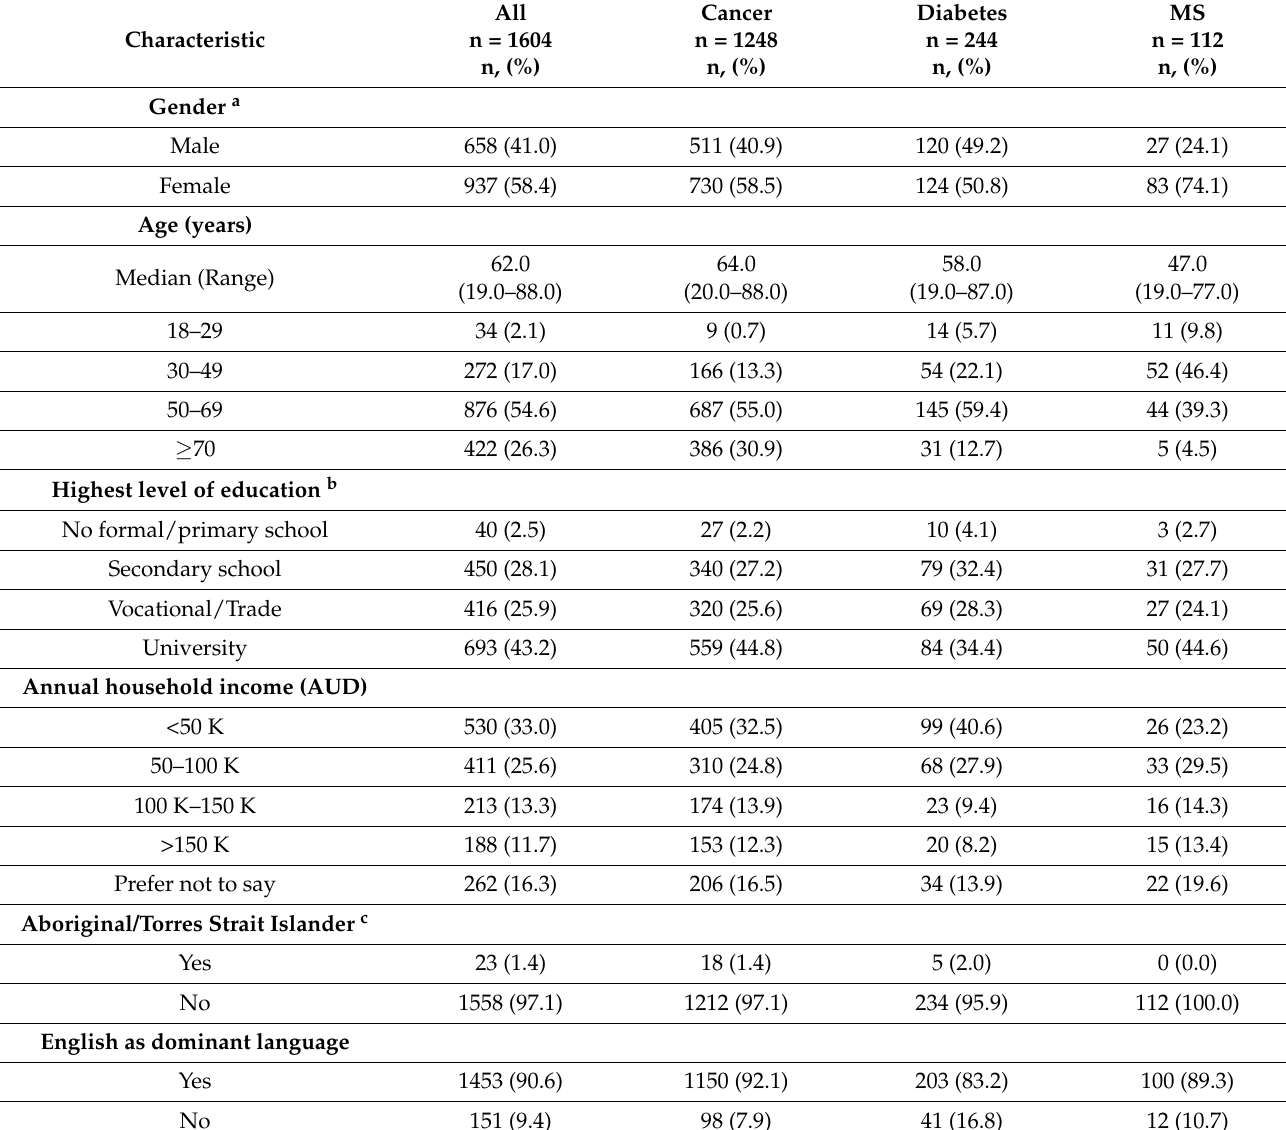
Table 1. Characteristics of participants who provided free-text comments by underlying